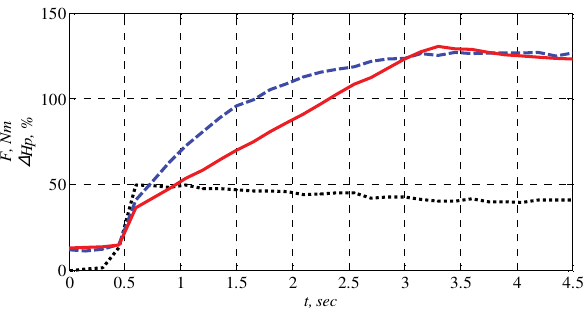
Fig. 3. Discrepancy D Hp ( ···· ) and push F on the output lever: ––– “inte- gral” method; - - - “isodromic” method Additionally it can be illustrated by the rate of change in push during transient process, which in physical sense is the derivative of dF/dt that is shown in Fig. 4. It can be also seen from the chart that in the case of “isodromic” method, the transient process is finished for 1.5 seconds earlier and has no overregulation. It has, undoubtedly, a positive im- pact on increasing the stability and operation speed of the entire automatic control system.